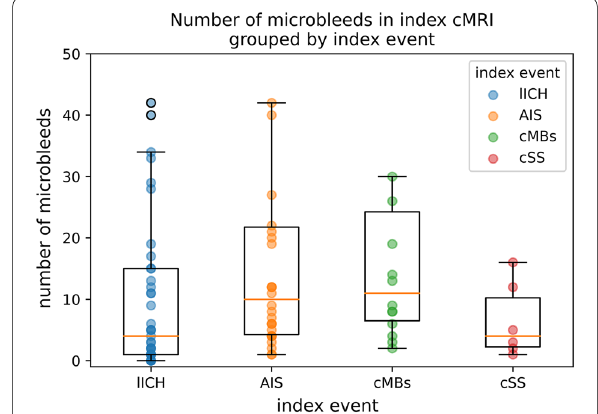
Fig. 5 Number of microbleeds in index MRI grouped by index event for patients with the diagnosis of probable CAA. Each patient is represented by one data point in the plot, overlying are boxplots. Please note that a cut‑off was set at 50